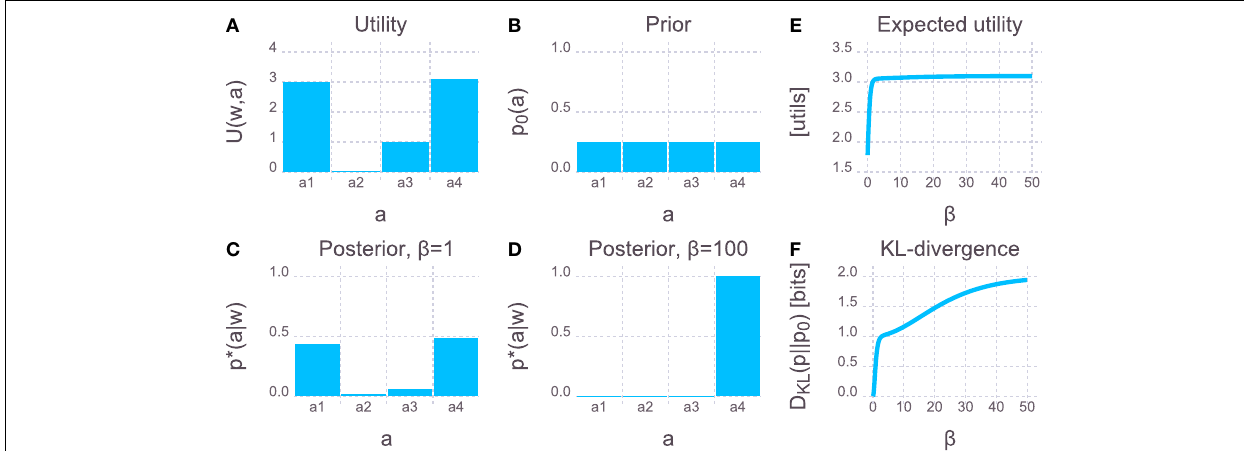
FIGURE 1 | Bounded rationality and the free energy principle . Imagine an actor that has to grasp a particular cup w from a table. There are four options a 1 to a 4 to perform the movement and the utility U ( w , a ) shown in (A) measures the performance of each option. There are two actions a 1 and a 4 that lead to a successful grasp without spilling, and a 4 is minimally better. Action a 3 leads to a successful grasp but spills half the cup, and a 2 represents an unsuccessful grasp. (B) Prior distribution over actions p 0 ( a ): no preference for a particular action. (C) Posterior p *( a | w ) [equation (4)] for an actor with limited computational capacity. Due to the computational limits, the posterior cannot deviate from the prior arbitrarily far, otherwise the KL-divergence constraint would be violated. The computational resources are mostly spent on increasing the chance of picking one of the two successful options and decreasing the chance of picking a 2 or a 3. The agent is almost indifferent between the two successful options a 1 and a 4. (D) Posterior for an actor with large computational resources. Even though a 4 is only slightly better than a 1, the agent is almost unbounded and can deviate a lot from the prior. This solution is already close to the deterministic maximum expected utility solution and incurs a large KL-divergence from prior to posterior. (E) Expected utility E p (cid:3) ( a j w ) [ U ( w , a )] as a function of the inverse temperature (cid:12) . Initially, allowing for more computational resources leads to a rapid increase in expected utility. However, this trend quickly flattens out into a regime where small increases in expected utility imply large increases in (cid:12) . (F) KL-divergence D KL ( p *( a | w )|| p 0 ( a )) as a function of the inverse temperature (cid:12) . In order to achieve an expected utility of (cid:25) 95% of the maximum utility roughly 1bit suffices [leading to a posterior similar to (C) ]. Further increasing the performance by 5% requires twice the computational capacity